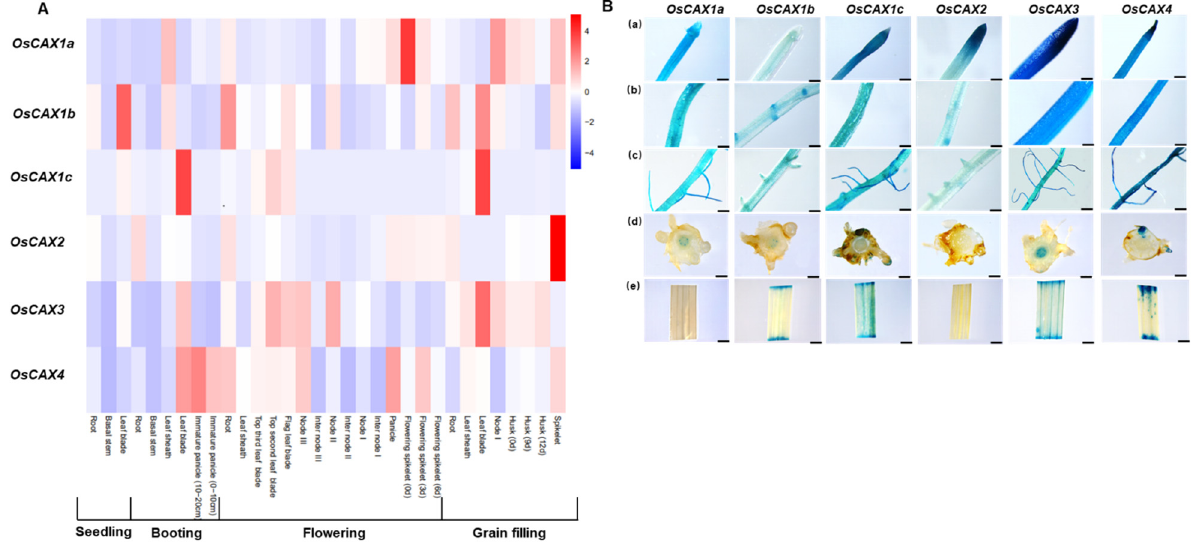
Figure 4. Tissue expression pattern. ( A ) Relative expression of rice CAX members in various tissues at different growth stages. Various tissues samples were taken from cv. Nipponbare grown in a paddy field. ( B ) Localization of pOsCAXs-GUS expression in transgenic rice plants. GUS staining pattern in tissues of 14-day-old seedlings cultured with de-ionized water: ( a ) root tip, ( b ) 2 to 3 cm from the root tip, ( c ) root lateral branching zones, ( d ) hand-cut cross-section of the root–shoot junction and ( e ) leaves. ( a – c ) Scale bar = 0.5 mm. ( d , e ) Scale bar = 2 mm.